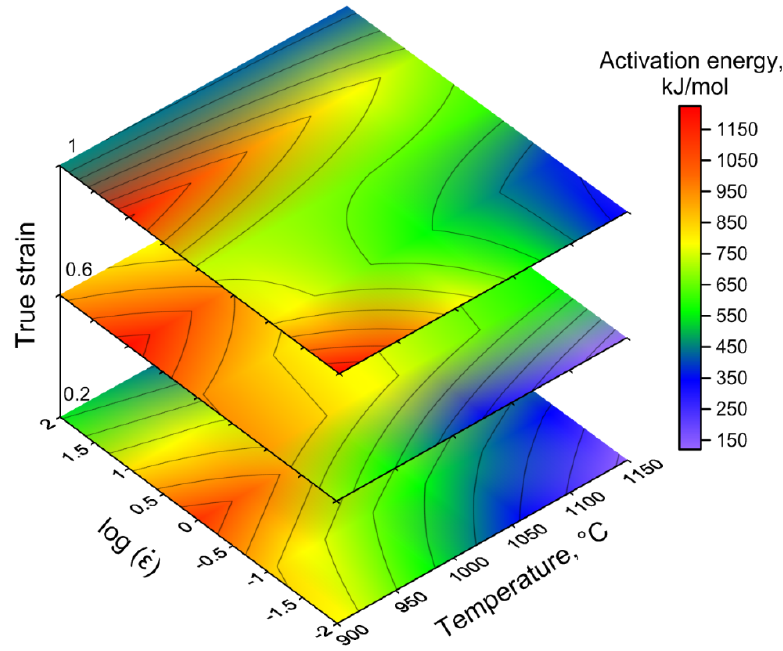
Figure 4. The deformation activation energy map for Waspaloy at true strains of 0.2, 0.6, and 1.